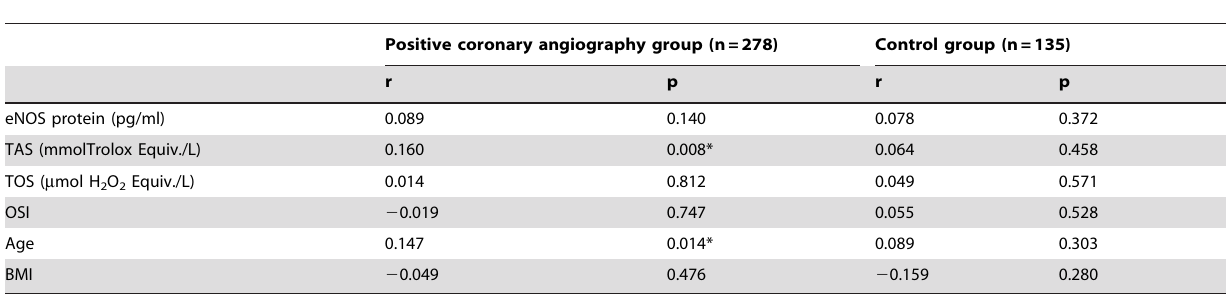
Table 4. Results of Pearson’s correlation between expression level of SIRT1 and other parameters.